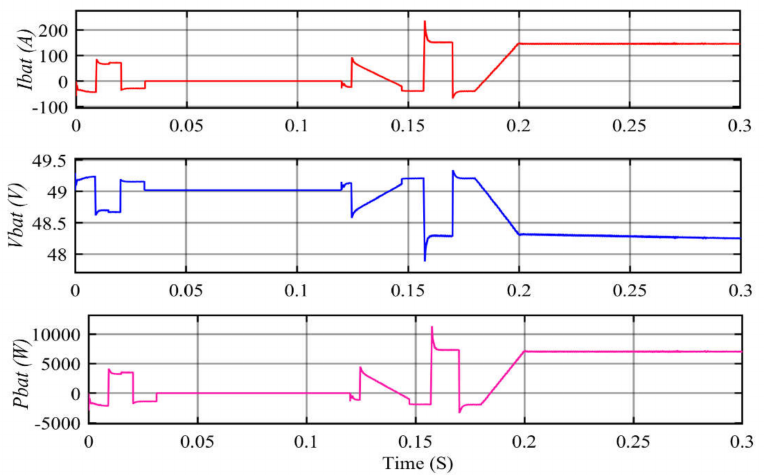
Figure 12. Changes in the battery’s current, voltage, and power under load and radiation